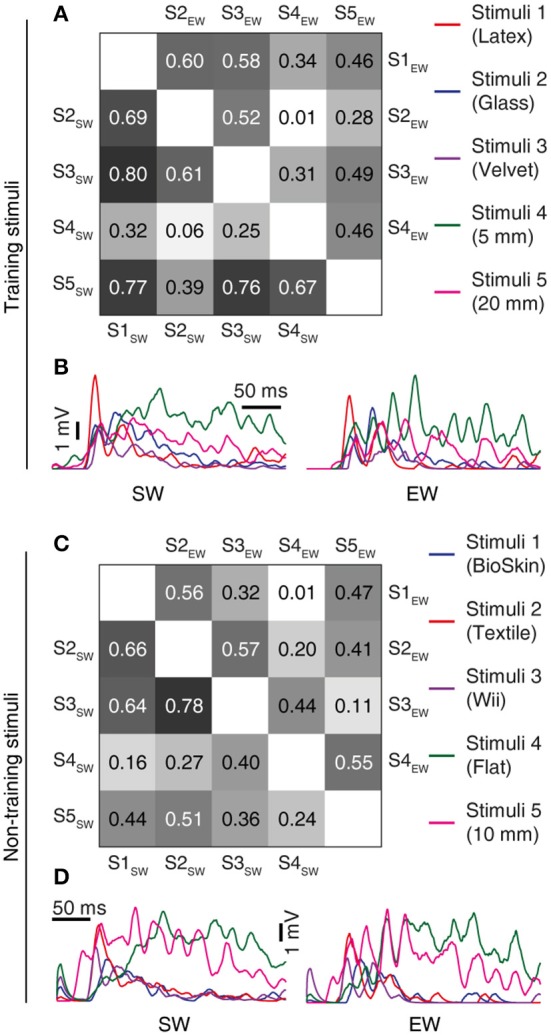
Learning resulted in decorrelation of the responses to different stimuli in the individual CN. (A) Triangle matrix for the correlations between synaptic responses evoked by the training stimuli before and after learning in the same CN. Otherwise the display is similar to Figure 7A. The difference in correlation before and after learning was statistically significant (p < 0.001, Wilcoxon signed rank test) (B) Averaged synaptic responses of the CN (CN1) to the full set of training stimuli. (C,D) Similar display as in (A,B) but for non-training stimuli previously reported for shapes (Oddo et al., 2017) and for textures (Rongala et al., 2017). The difference in correlation between the two groups was statistically significant (p = 0.028, Wilcoxon signed rank test).